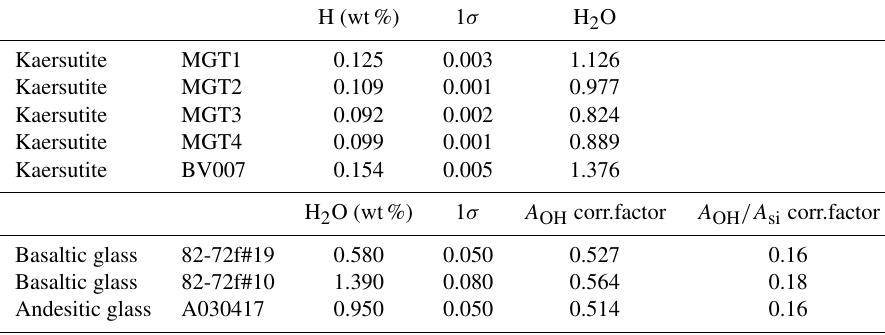
Table 3. Water content of the amphibole standards and reference